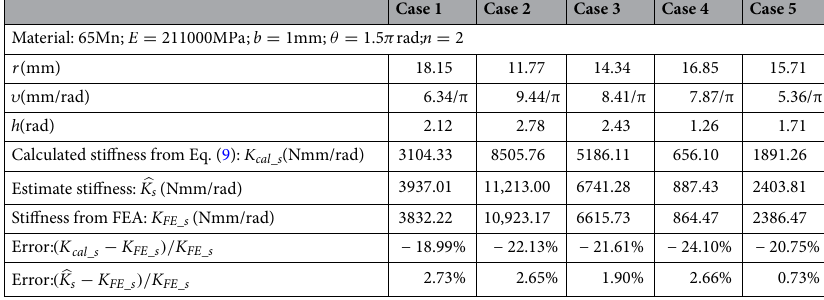
Table 3. Parameters and stiffness comparison of two-arm planar spiral springs.